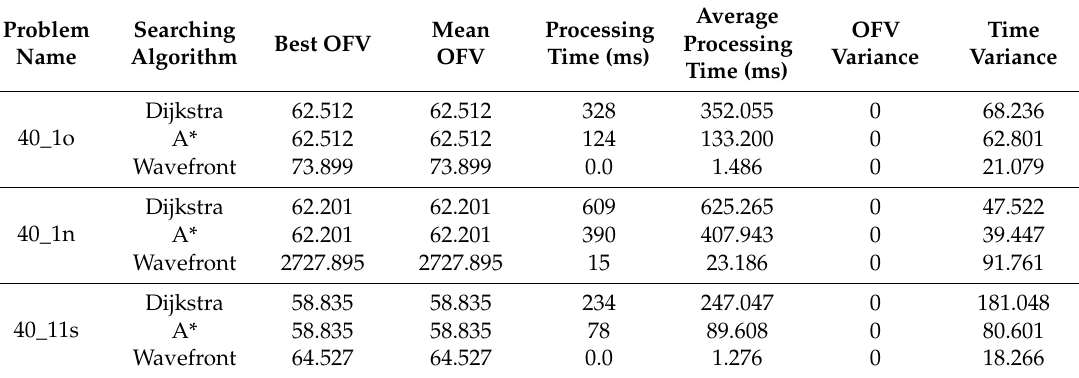
Table 15. Experimental results of the other algorithms within 40 × 40 case.